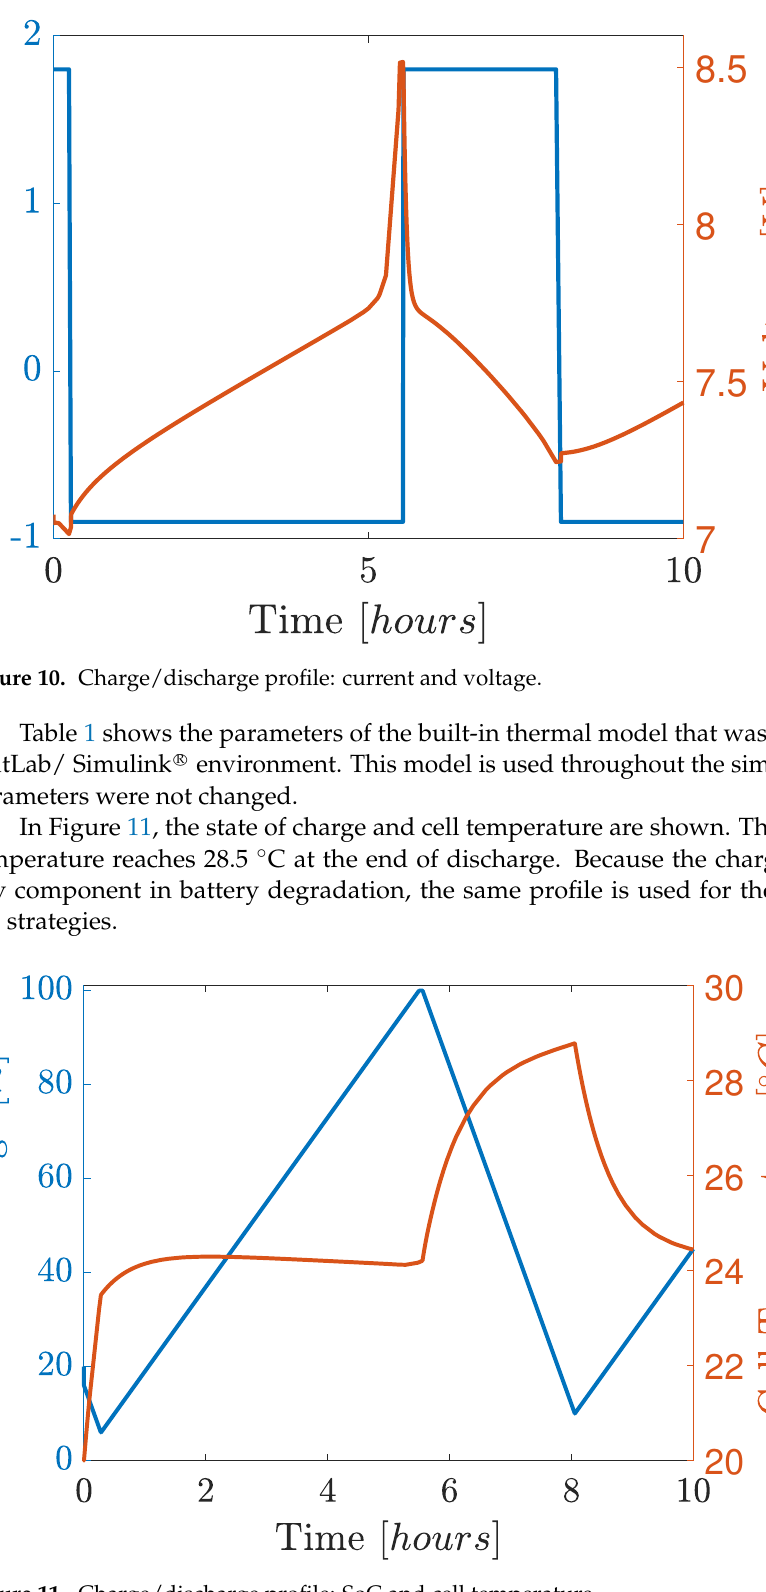
Figure 11. Charge/discharge profile: SoC and cell